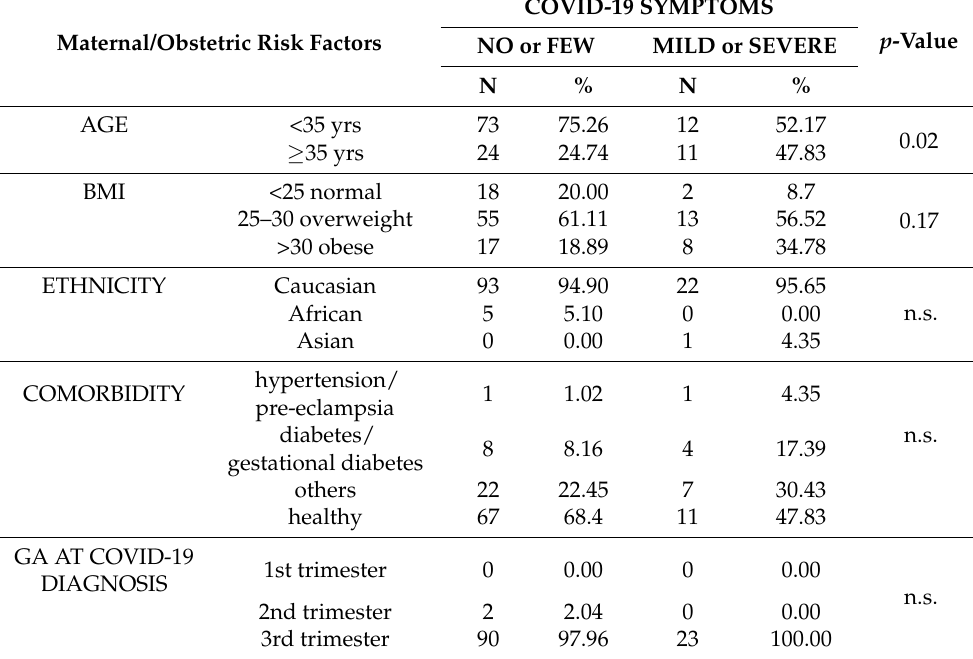
Table 3. The correlations between maternal or obstetric risk factors and COVID-19 disease severity. LEGEND: OVB (operative vaginal birth), SVB (spontaneous vaginal birth), CS (cesarean